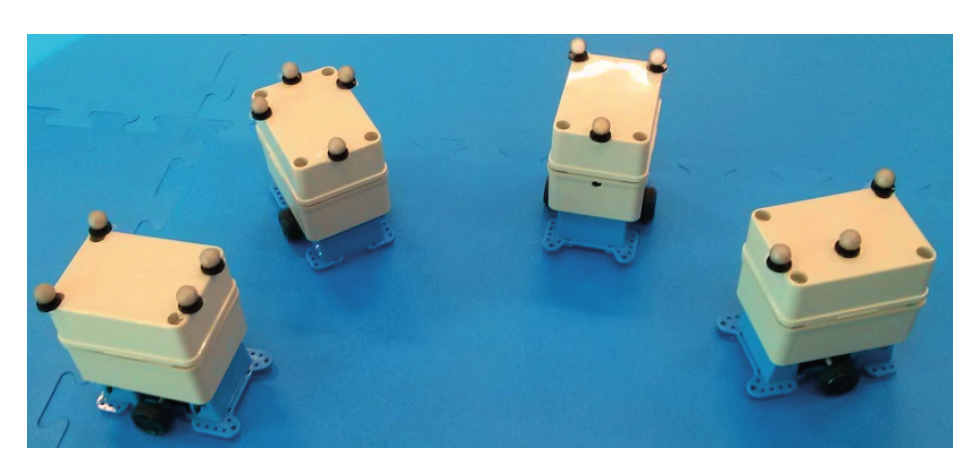
Figure 12. The multi-robot system with four